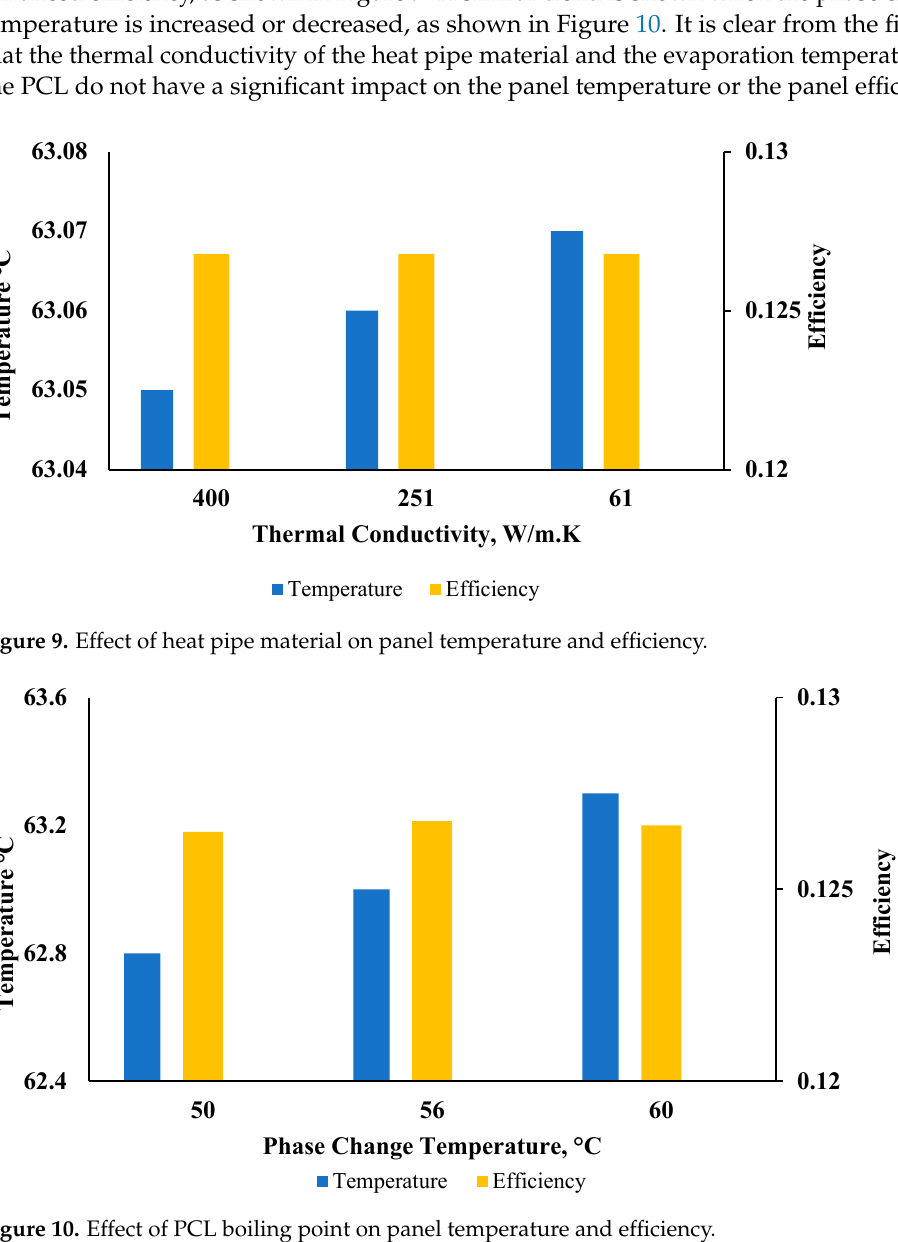
Figure 10. Effect of PCL boiling point on panel temperature and efficiency .